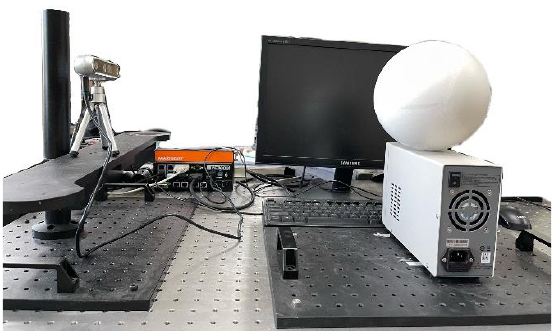
Figure 15. 3D reconstruction experiment using Intel Realsense D455.